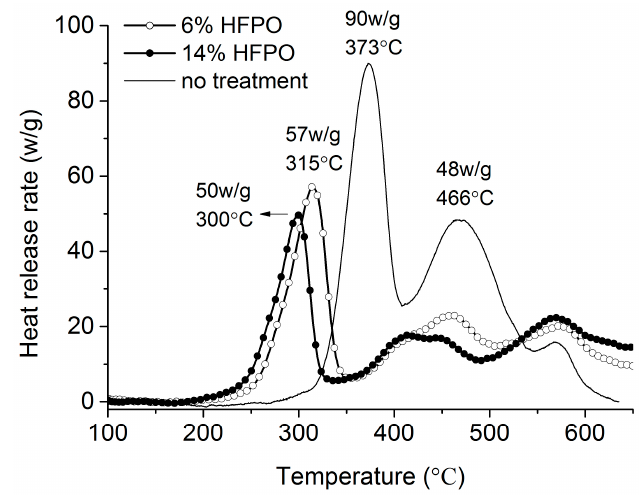
Figure 5. The heat release rate vs. temperature curves of the Nomex ® /cotton fabric treated with 3% BTCA and: (1) no HFPO; (2) 6% HFPO; and (3) 14% HFPO, cured at 170 °C for 3 min and finally subjected to one home laundering cycle.